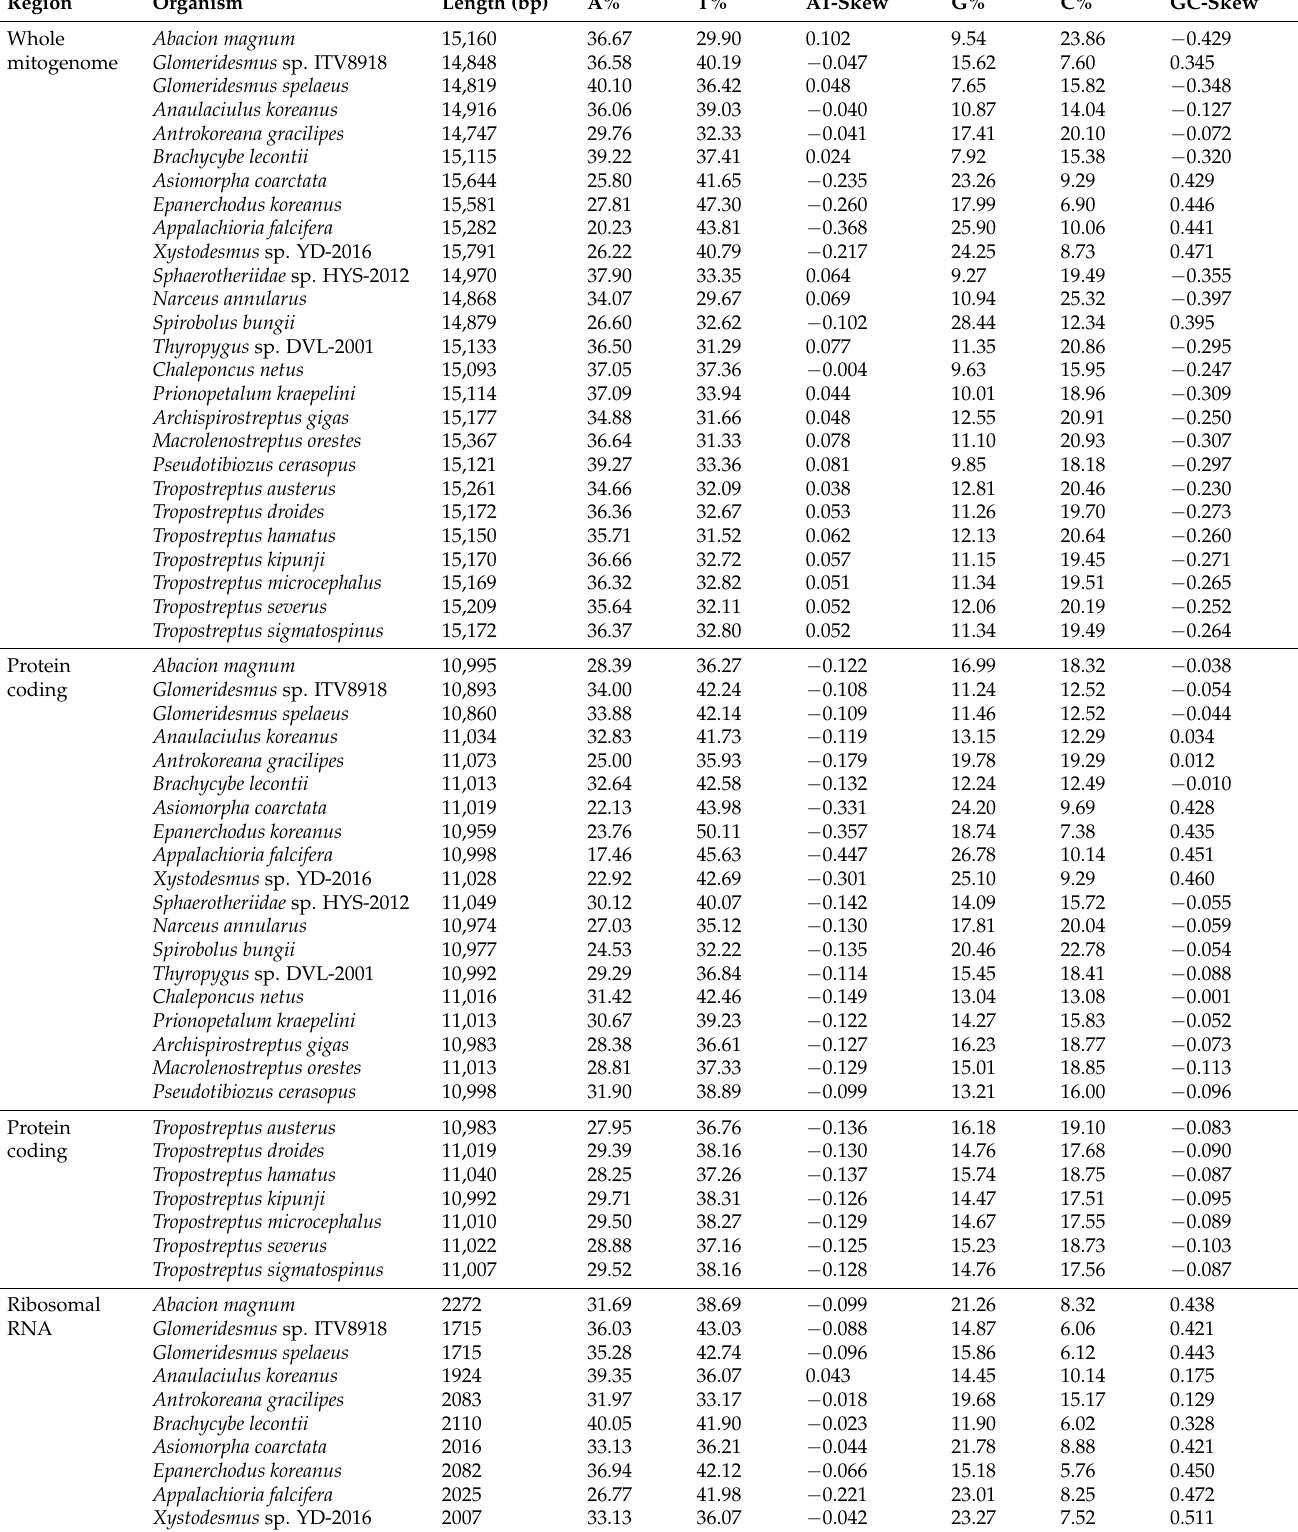
Table A1. Nucleotide composition indices in different regions of Diplopoda